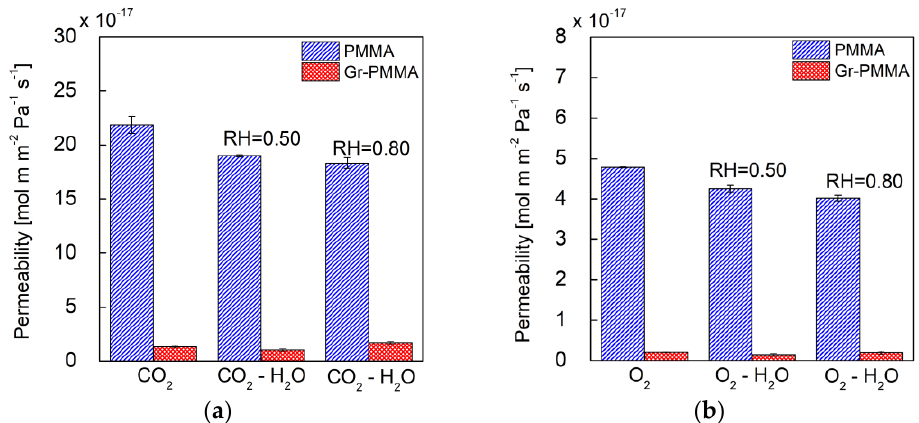
Figure 4. Gas permeability coefficients at 25 °C through PMMA (blue bars) and Gr-PMMA (red bars) for ( a ) CO 2 and humidified CO 2 and for ( b ) O 2 and humidified O 2 . Table 1. Permeability coefficients of CO 2 through the nanolaminates at different R.H. levels.